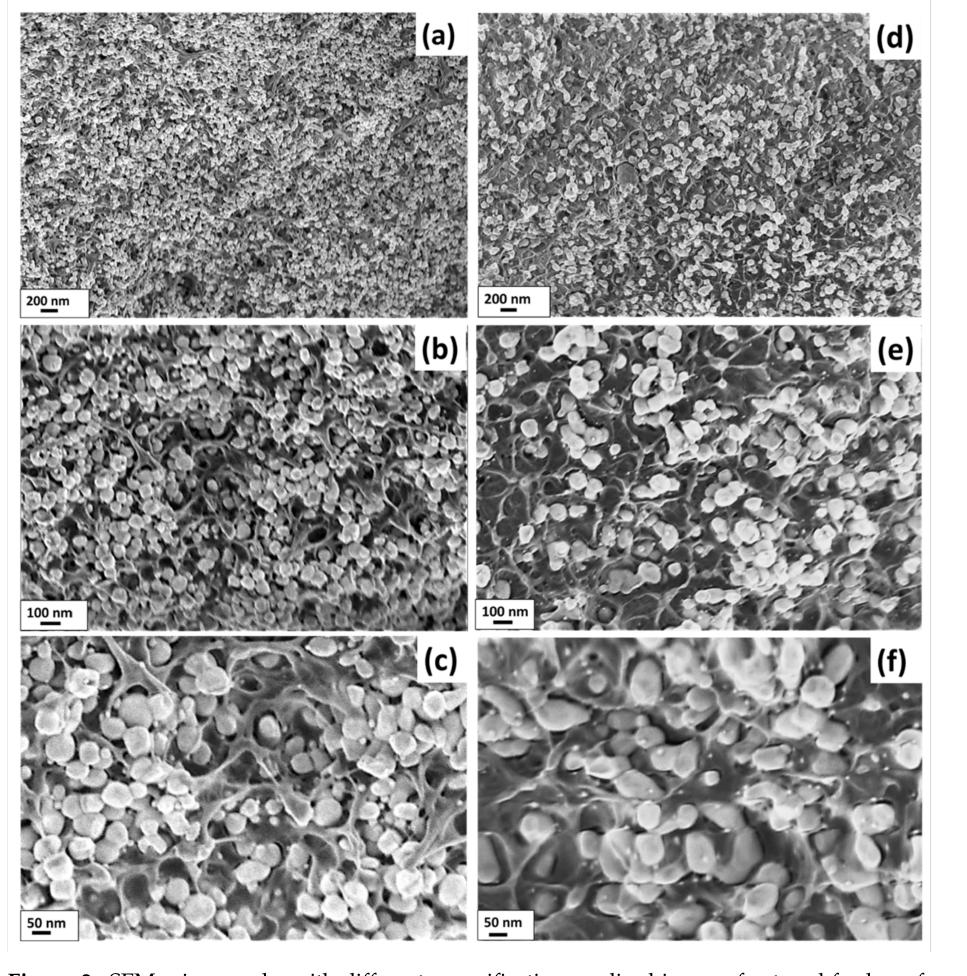
Figure 3. SEM micrographs with different magnifications realised in cryo-fractured fresh surfaces of 20%( x Ag − (1 − x )BT) − 80%PVDF thick films with two compositions: ( a – c ) x = 2 vol.%, ( d – f ) x = 27